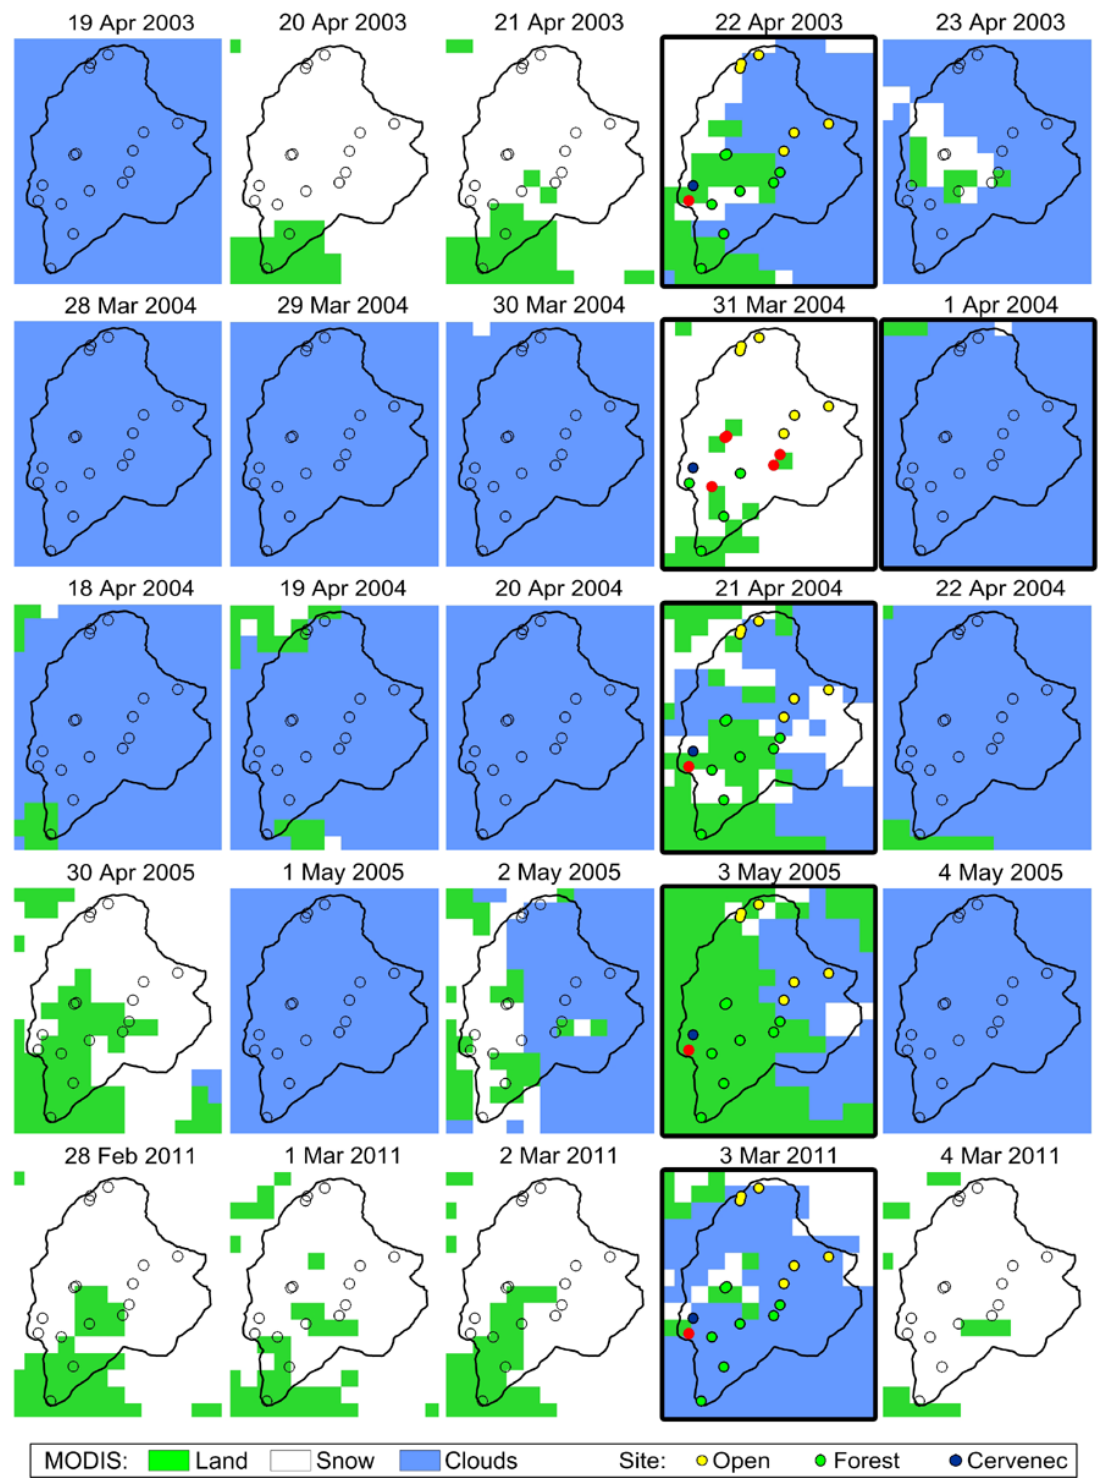
Fig. 7. Misclassification of snow as land by the combined MODIS product and 2-day filter of the combined product at forest sites (Fig. 6). The maps in black frames show the date of ground snow measurements; red circles indicate the sites where misclassification occurs.